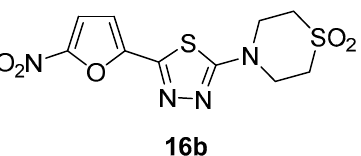
Figure 4. Structure of 4-[5-(5-nitrofuran-2-yl)-1,3,4-thiadiazol-2-yl]thiomorpholine-1,1-dioxide ( 16b ).